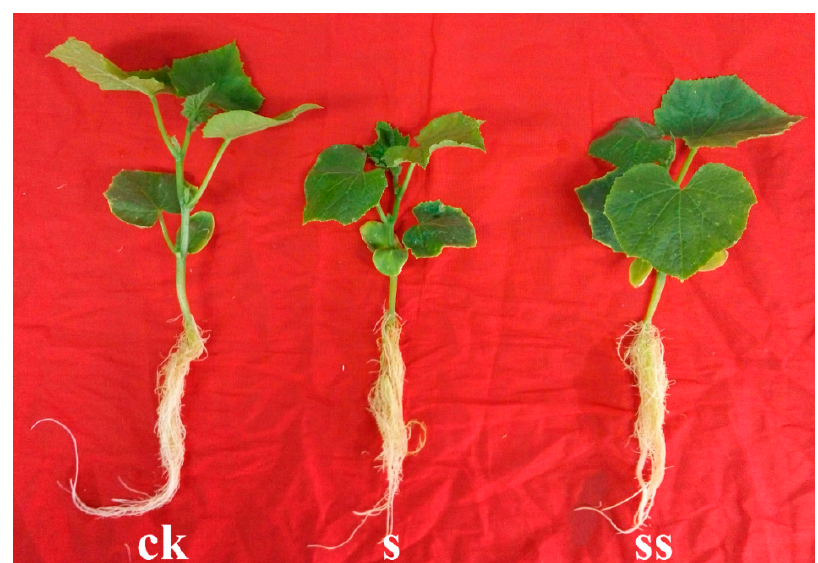
Figure 1. Effect of spermidine (Spd) on plant growth of cucumber seedlings under salt stress after 5-day treatment. CK = control, S = 75 mM NaCl, SS = 75 mM NaCl + 0.1 mM Spd.